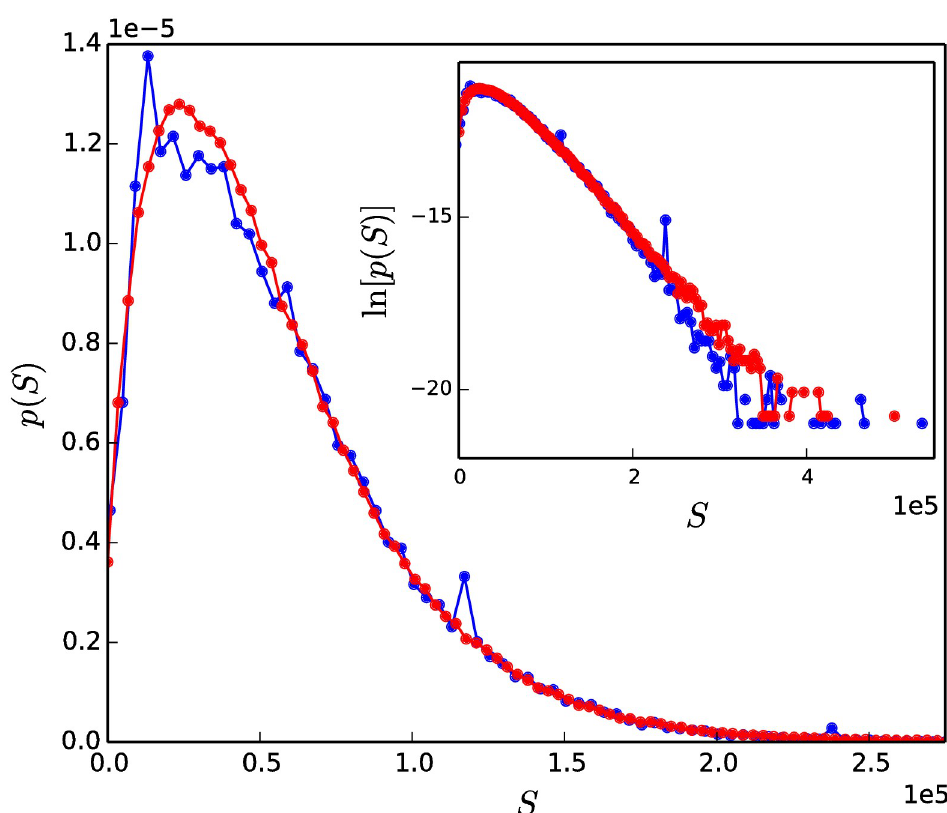
Fig 9. Fit of original (two-parameter) model status distribution to Canadian household income distribution. Simulated distribution (red curve, δ = 0.35 and α = 0), compared to the distribution of Canadian household incomes from the year 2000 (blue curve). Scaled variance, M = � S ¼ 0 : 536 and skewness, γ = 1.3 for the simulated distribution, 2 and M = � S ¼ 0 : 534 and γ = 1.4 for the proxy distribution. The x-axis of the main plot has been cut at S = 2.5 × 10 5 . The 2 large peak in the data at $12, 000 ( S = 0.12 × 10 5 ) is most likely due to welfare benefits provided by the government, and the peak at $12, 000 ( S = 1.2 × 10 5 ) comes from an upper income cutoff applied to the public-use data by Statistics Canada [72].